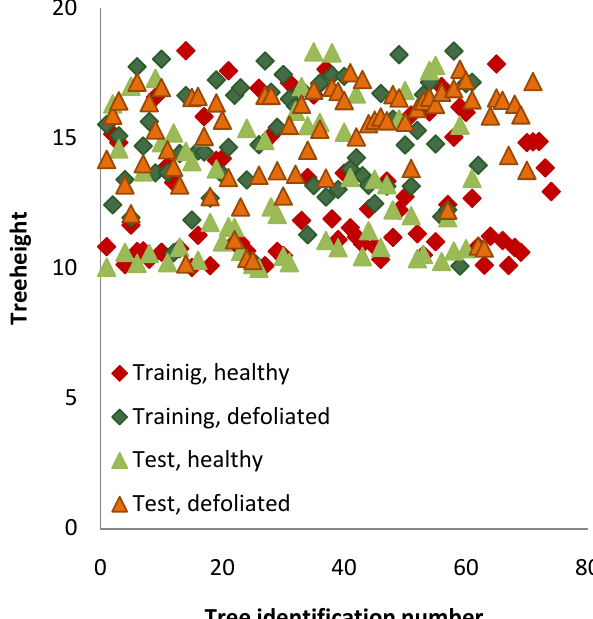
Figure 2. Plotted heights of healthy and defoliated trees. The x axis presents